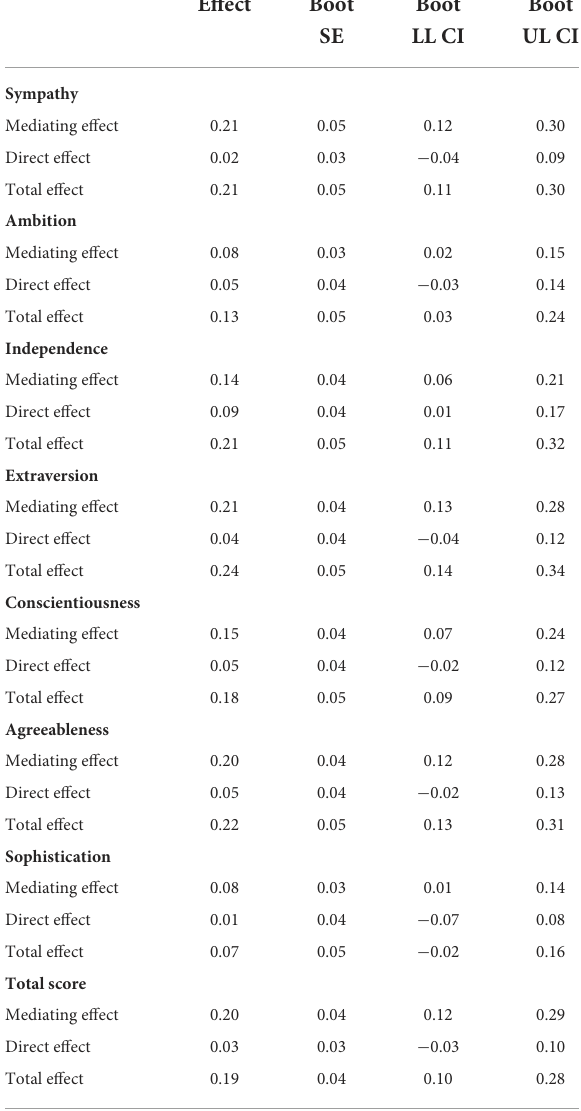
TABLE 3 Mediating effect, direct effect, and total effect among the